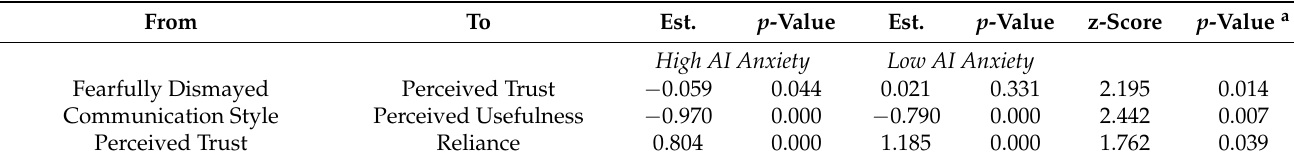
Table 12. Local multi-group moderation difference effect